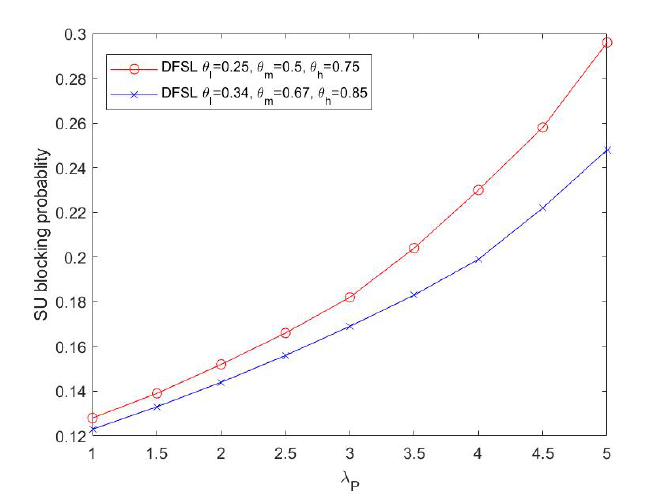
Figure 10. SU blocking probability versus λ P